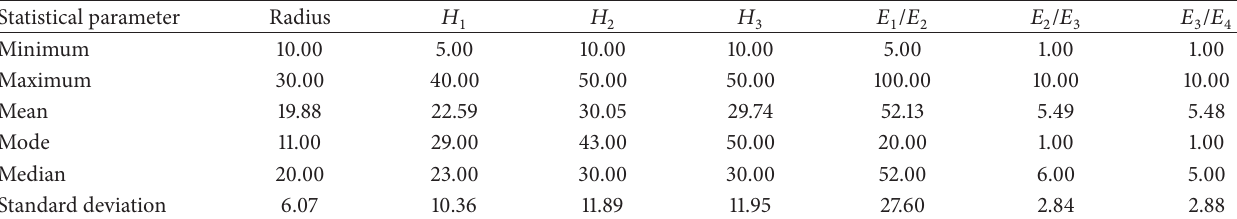
Table 1: Ranges of analytical dataset.